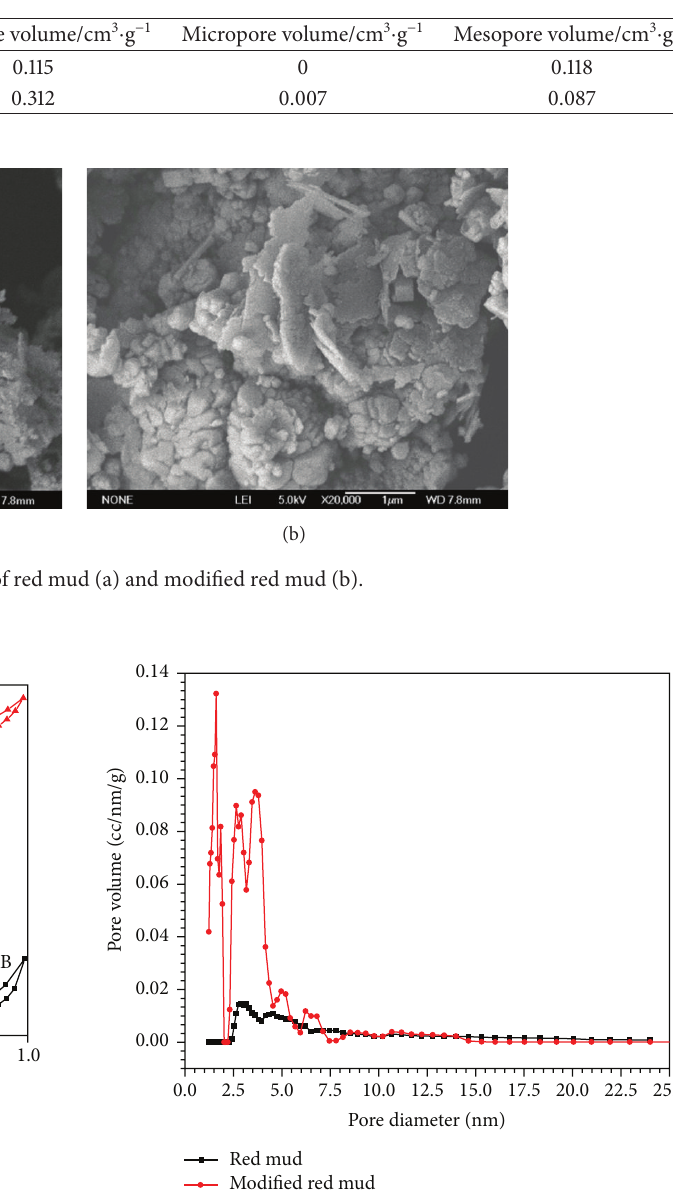
Table 2: Pore structure parameters of red mud and modified red mud.